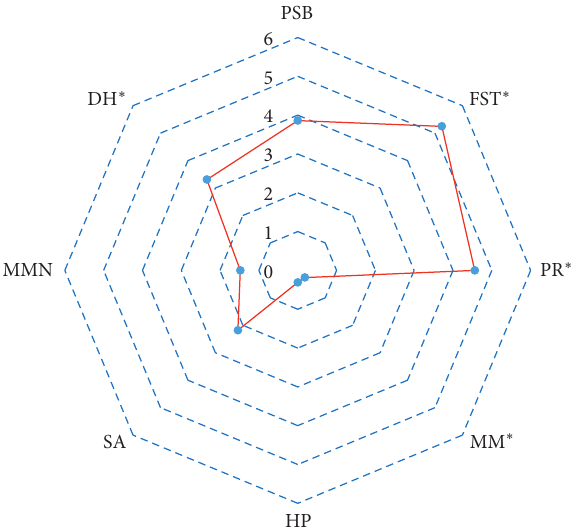
Figure 3: Woody basal area in the different green spaces. Pre- fecture garden (HP), Saint-Anne garden (SA), Marien Ngouabi Museum garden (MMN), Ministry of Mines square (MM), Pierre Savorgnon De Brazza garden (PSB), Rotary Club square (PR), Faculty of Science and Technology square (FST), Human rights square (DH), and ( ∗ ) data relating to areas of less than